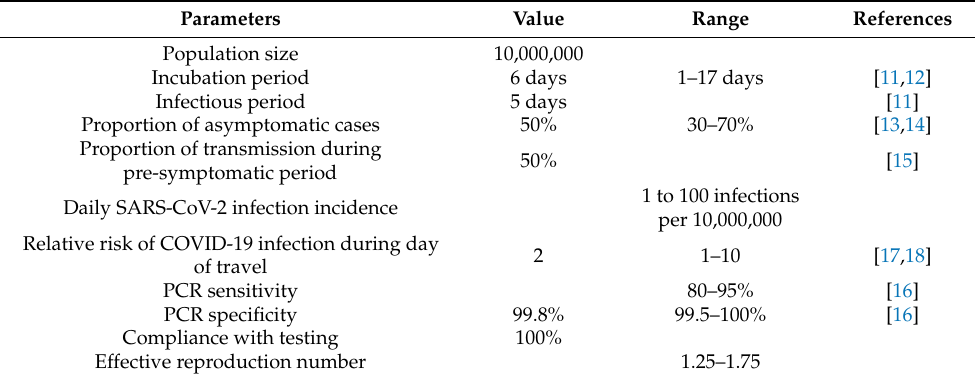
Table 1. Parameters of microsimulation and extended SEIR